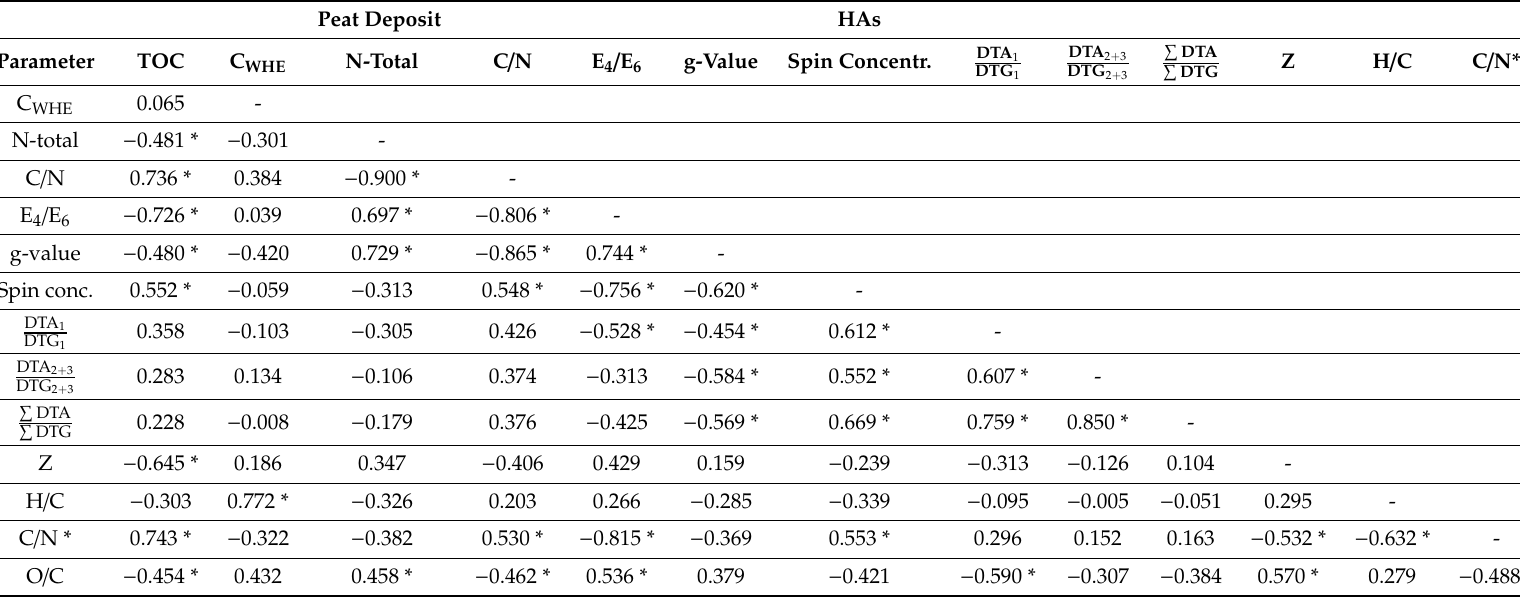
Table 9. Correlation coe ffi cients between chemical properties of peat deposits, VIS-spectroscopy, electron paramagnetic resonance, and thermal decomposition of HAs. Peat Deposit HAs Parameter TOC C WHE N-Total E 4 / E 6 g-Value Spin